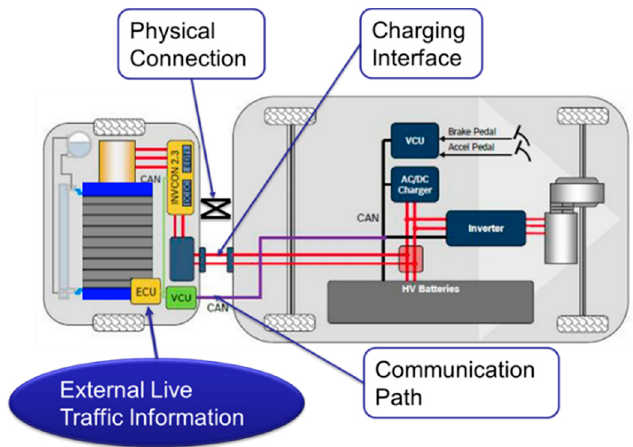
Figure 4. Intelligent FC range extender demonstration.